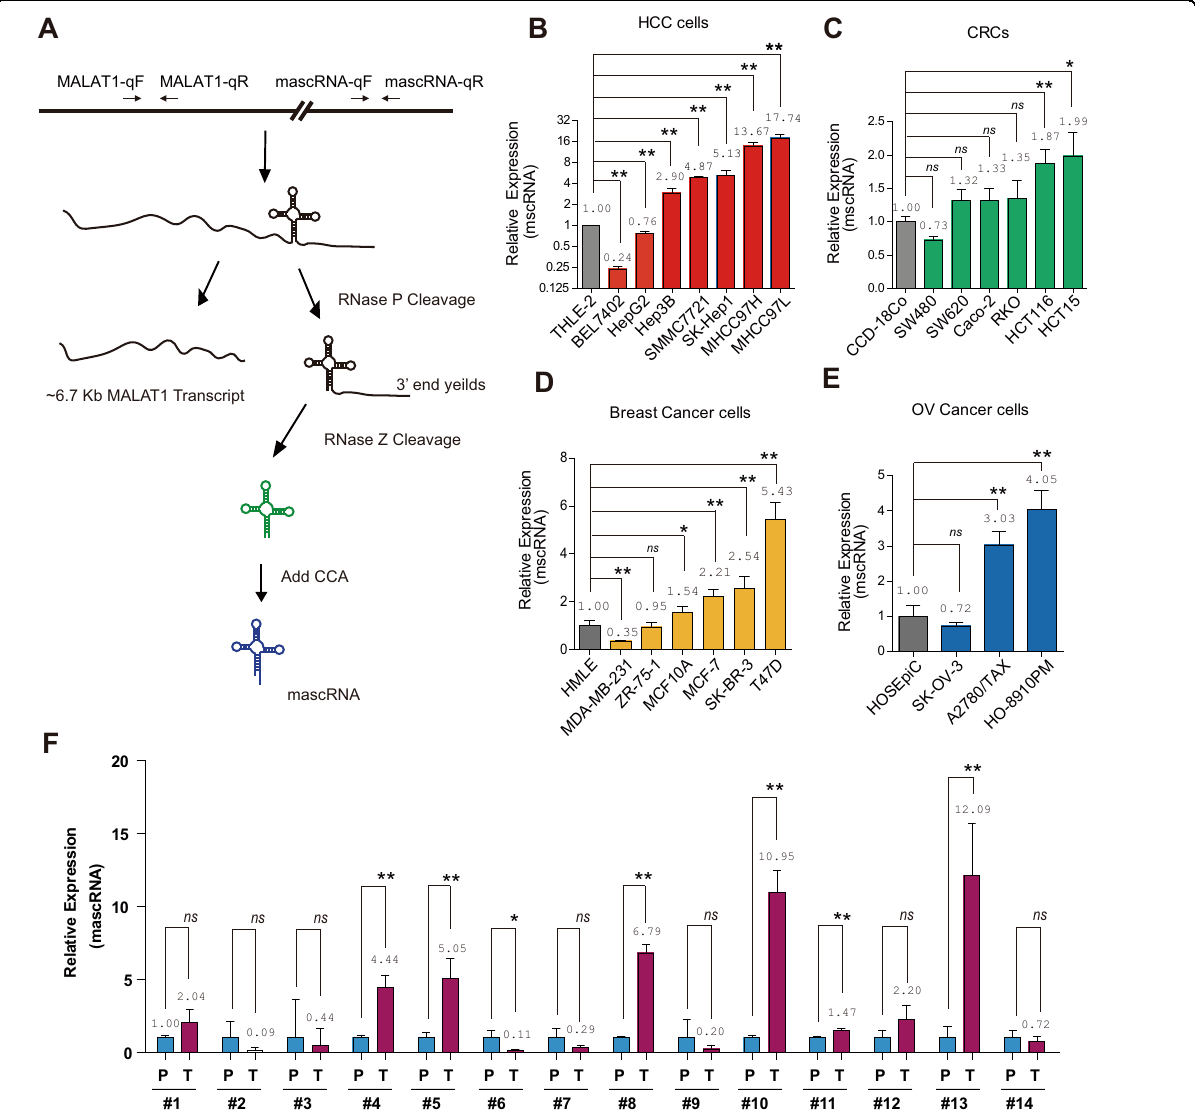
Fig. 1 mascRNA is enriched in multiple cancer cell lines and HCC clinical samples. A Schematic diagram of mascRNA biogenesis. The position of primers for real-time RT-PCR of mature mascRNA or MALAT1 were marked with arrows on the upper diagram. mascRNA expression levels were measured by real-time RT-PCR in ( B ) normal hepatocyte THLE-2 and seven liver cancer cell lines (BEL7402, HepG2, Hep3B, SMMC-7721, SK-Hep1, MHCC97H, and MHCC97L), C normal colorectal cell line CCD-18Co and six colorectal cancer cell lines (SW480, SW620, Caco-2, RKO, HCT116, and HCT15), D HMLE and six breast cancer cell lines (MDA-MB-231, ZR-75-1, MCF10A, MCF-7, SK-BR-3, and T47D), E HOSEpiC and three ovarian cancer cell lines (SK-OV-3, A2780/TAX, and HO-8910PM), respectively. F mascRNA expression levels in 14 human primary HCC tissue (T) and paracancer tissue (P). Quantitative data are represented as mean ± SD. * P < 0.05, ** P <